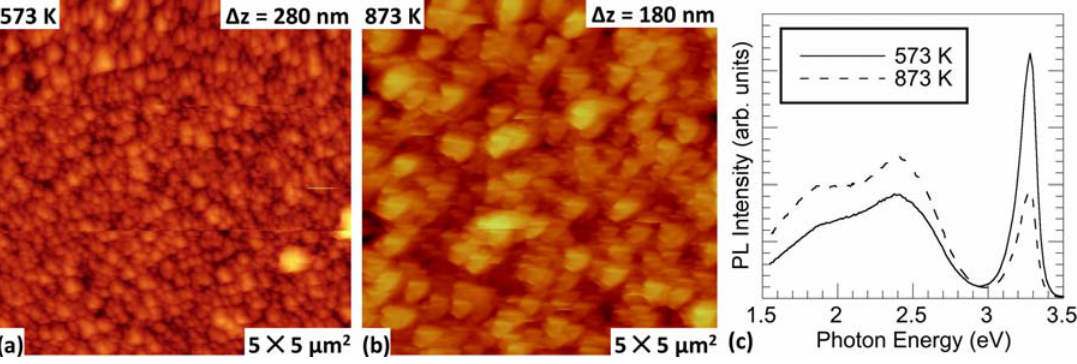
Figure 1. Atomic force microscopy (AFM) topography images of ZnO films fabricated via thermal oxidation of Zn metal films at an annealing temperature of ( a ) 573 K; and ( b ) 873 K; ( c ) The photoluminescence spectra of the same ZnO thin films showing yellow, green and excitonic emission at ∼ 2, 2.4 and 3.4 eV,